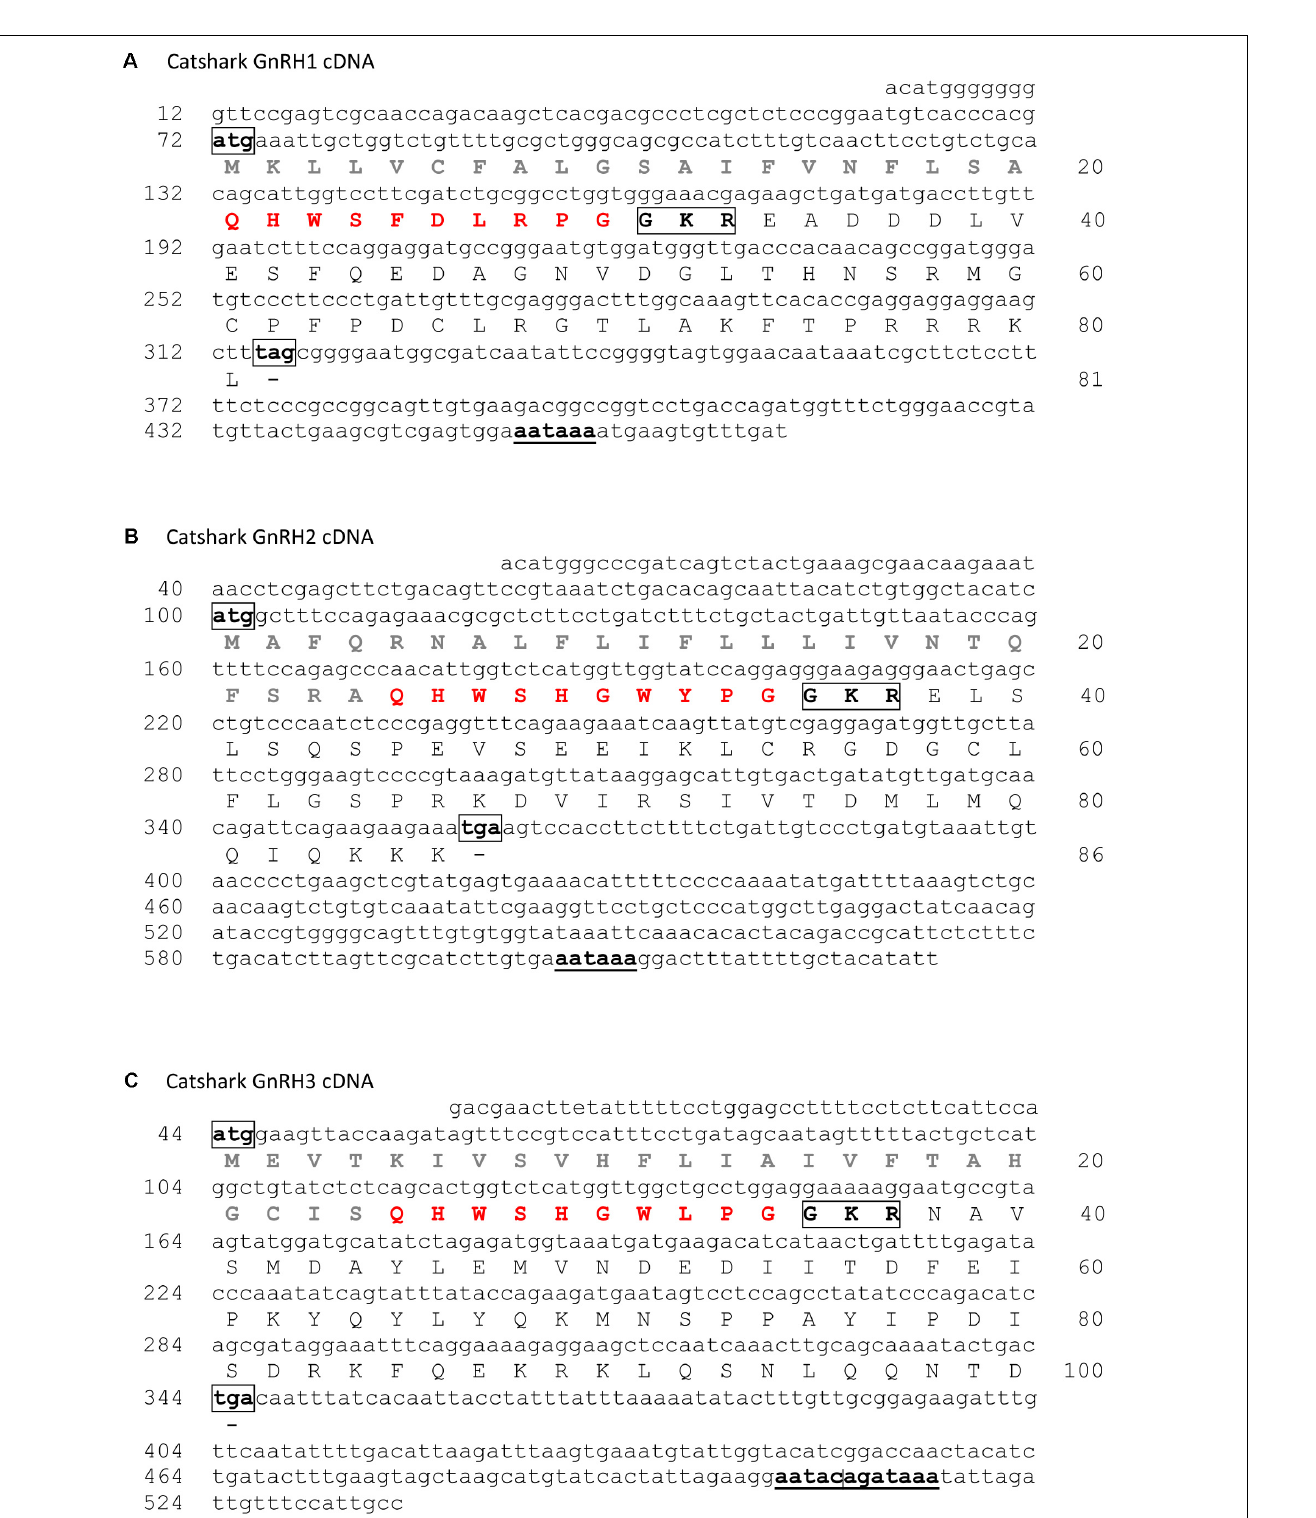
Frontiers in Neuroscience | www.frontiersin.org